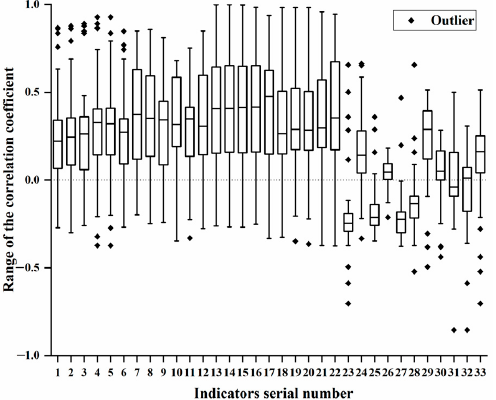
Figure 5. Correlation coefficients among the 33 IHA statistics.